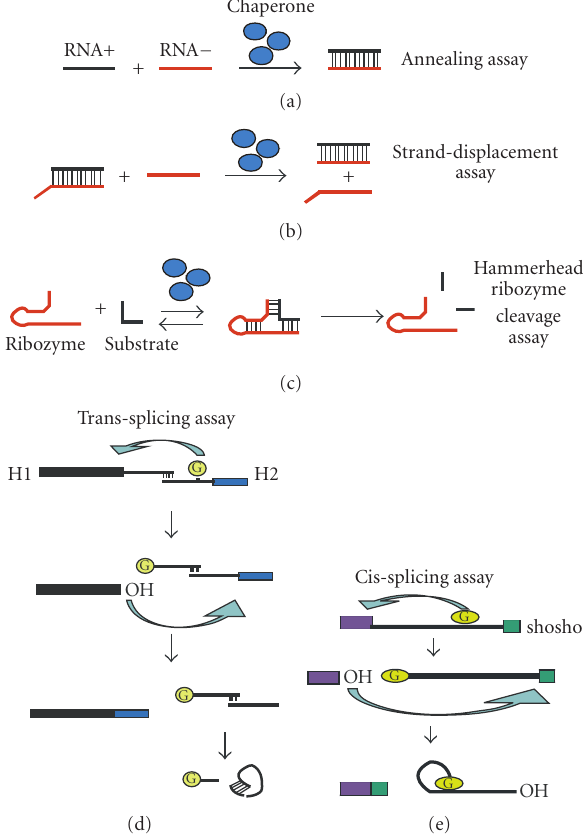
Figure 1: In vitro chaperone assays. (a) shows a simple annealing assay where two complementary RNA strands are annealed in the presence of RNA chaperones. (b) In the strand displacement assay, the RNA duplex is loosened and an alternative RNA helix is formed. (c) Hammerhead ribozyme cleavage is enhanced in the presence of chaperones. Under single turnover conditions, substrate to ribozyme annealing is measured. Under multiple turnover conditions substrate dissociation is measured. (d) In the trans-splicing assay, the group I intron is split in two halves H1 (upstream exon, 5 (cid:2) -part of the intron) and H2 (3 (cid:2) -part of the intron and exon2), and splicing at low temperatures in the presence of chaperones is measured. (e) shows the cis-splicing assay where an enhancement of splicing at 37 ◦ C is measured in the presence of chaperones. The construct (shosho) contains short exon 1 (27 nucleotides) and short exon 2 (2 nucleotides)